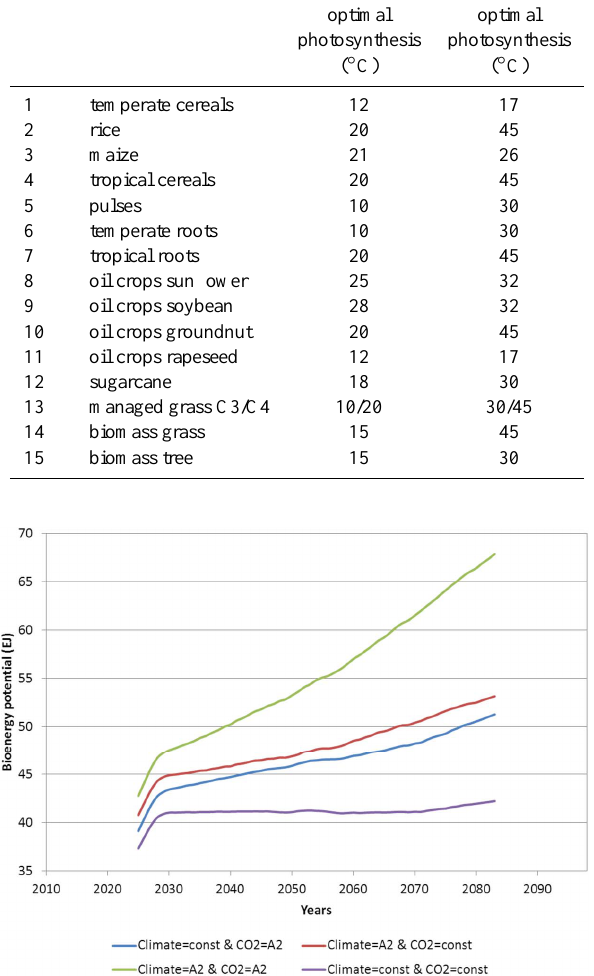
Fig. 8. Sensitivity of biophysical bioenergy potentials of the most plausible scenario, i.e. MAXL, to changes in climate (simulated by ECHAM5 model only) and/or CO 2 shown as a 30yr moving av- erage. The purple line at the bottom stands for the scenario where there is no change in climate or CO 2 , while the green line at the top represents the scenario where both climate as well as CO 2 change according to the SRES A2 scenario. The land use for all the sce- narios remain constant. Since perennial bioenergy grasses need a few years to reach full productivity in LPJmL, the total bioenergy potential is lower in the first years.